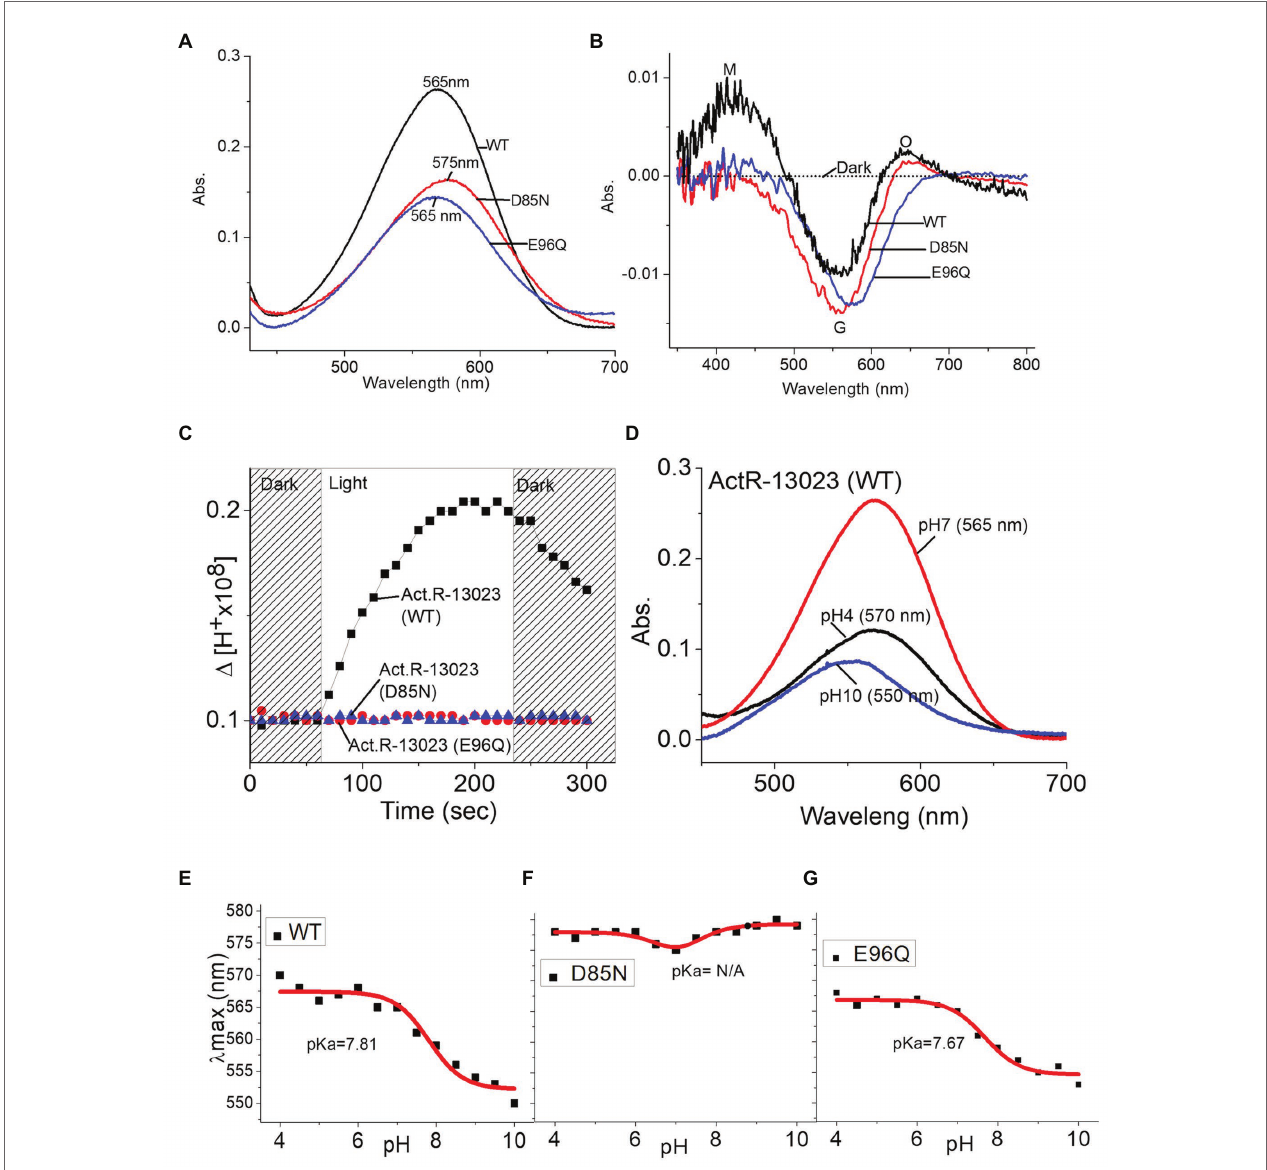
FIGURE 4 | Mutation studies of ActR-13023, wild-type ActR-13023, D85N, and E96Q mutants. (A) UV-visible spectra. (B) Light-induced differential spectra. (C) Proton pumping activities. pH titration and pKa calculation: (D) ActR-13023 spectra at pH 4, 7, and 10, (E) pKa value of ActR-13023, (F) pKa value of the D85N mutant, and (G) pKa value of the E96Q